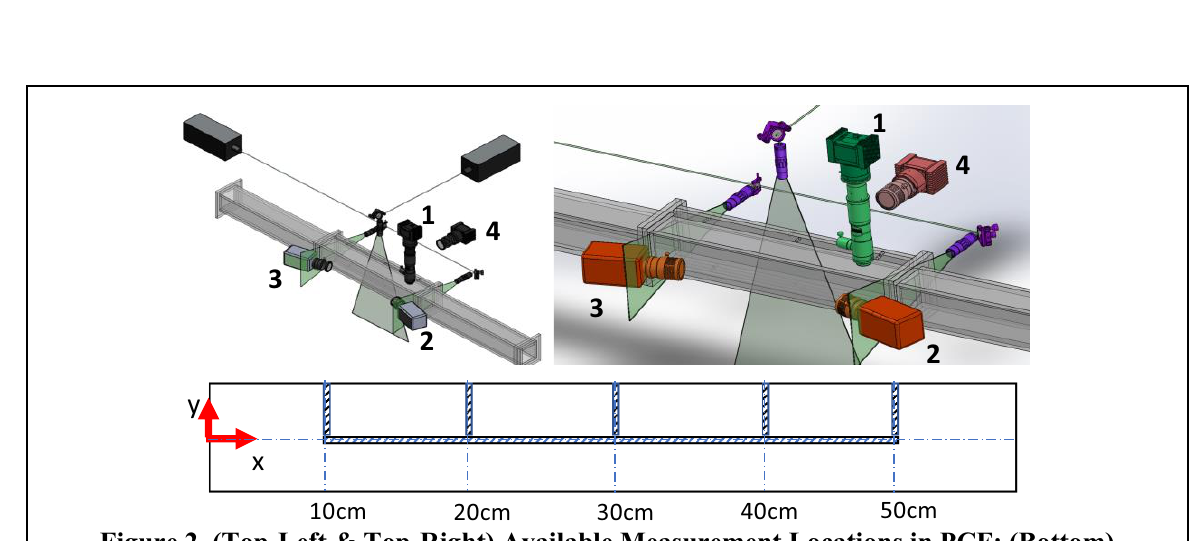
Figure 2. (Top-Left & Top-Right) Available Measurement Locations in PCF; (Bottom) Measurement Scan Locations for Particle Distribution Using Camera 1 along the Bottom